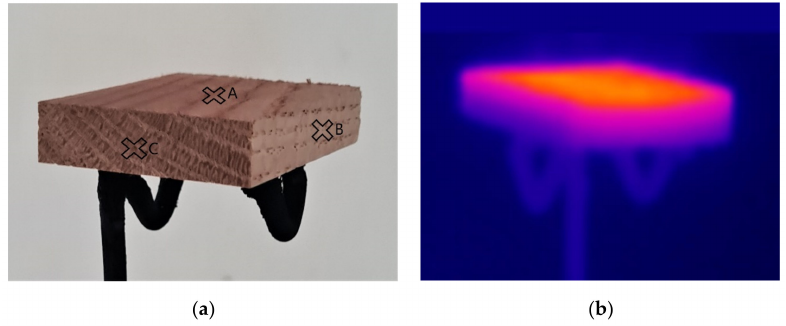
Figure 1. Locations for thermal camera measurement ( a ) and infrared snapshot ( b ). A—point on the top of the sample, B—point on the longer side of the sample, C—point on the shorter side of the